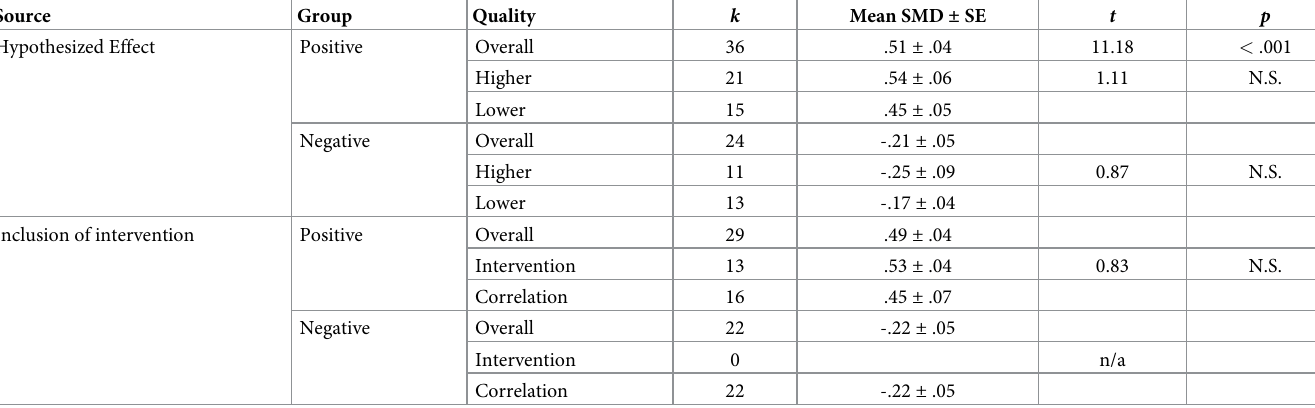
Table 3. Summary statistics for meta-analyses grouped by quality, hypothesized direction of effects, and inclusion of intervention/correlational